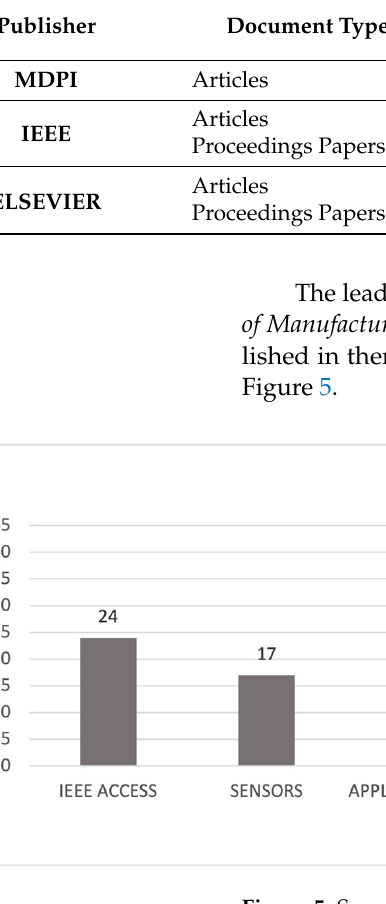
Figure 5. Sources of articles.